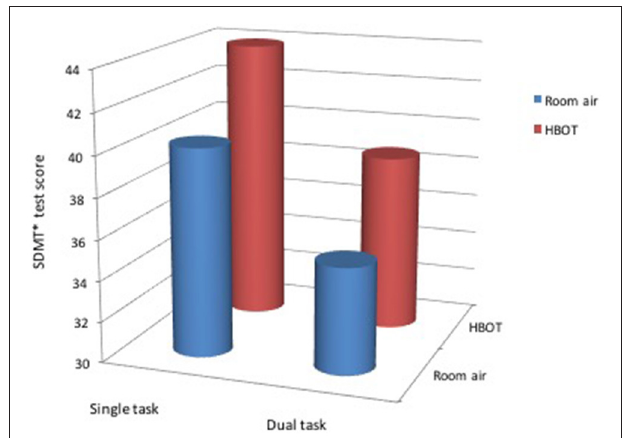
FIGURE 4 | General cognitive score during hyperbaric oxygen compared to normal environment. *SDMT—Symbol Digit Modality